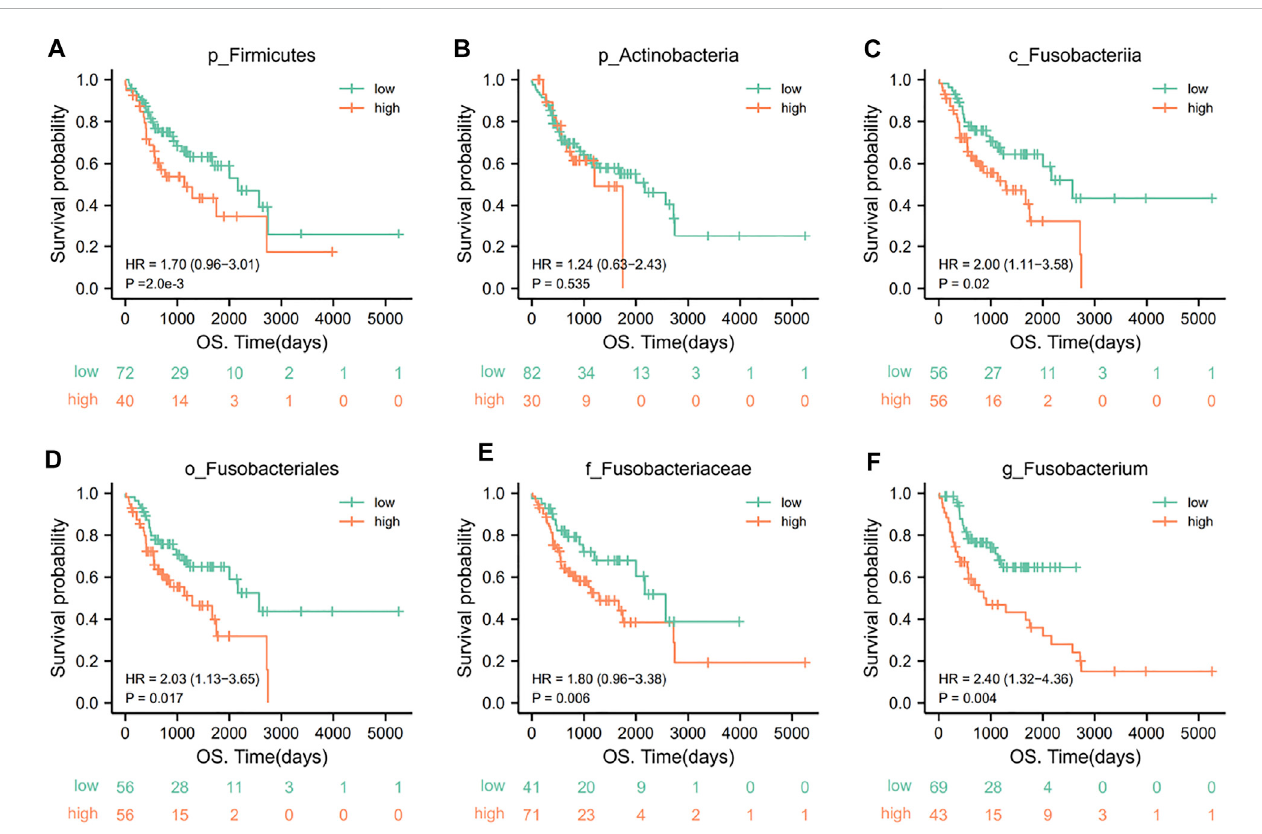
FIGURE 7 KM survival curves for key oral microorganisms in OSCC patients. A low abundance of p_Firmicutes (A) and high abundances of c_Fusobacteriia (C) , o_ Fusobacteriales (D) , f_Fusobacteriaceae (E) , and g_Fusobacterium (F) represented poor clinical outcomes ( p < .05). However, there was no signi fi cant relationship between p_Actinobacteria (B) and the outcome of patients ( p = .535) (grouping is best truncated based on speci fi c microbial abundance and divided into high and low